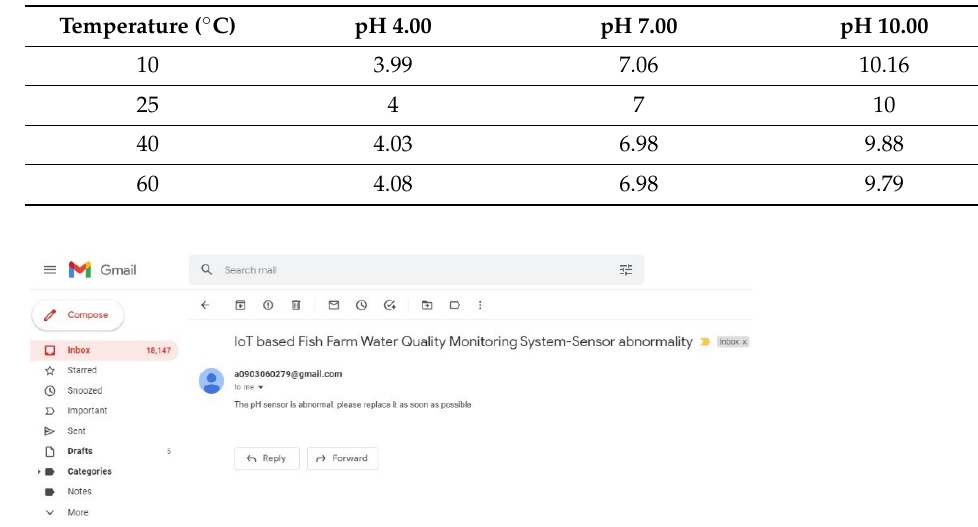
Figure 15. The alert